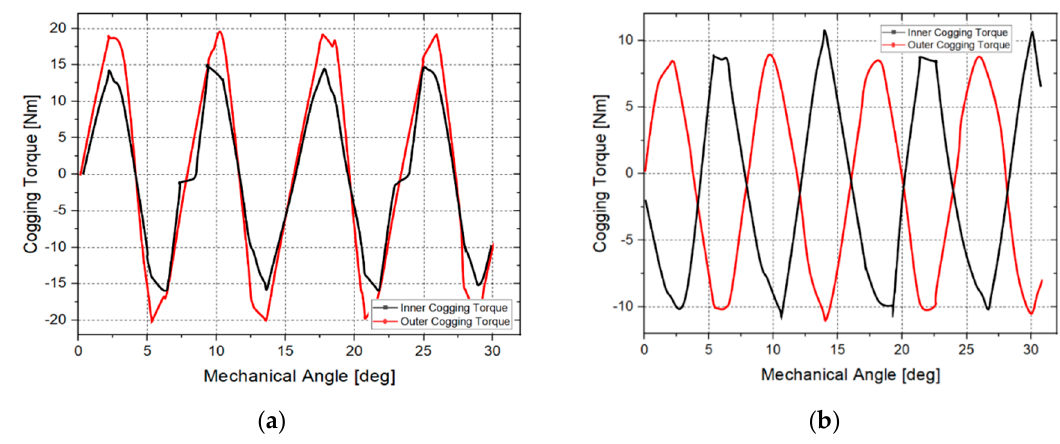
Figure 12. Results of cogging torque by adjusting the slot opening angle. ( a ) Sum of outer and inner cogging torques; ( b ) Sum of alternating outer and inner cogging torques.